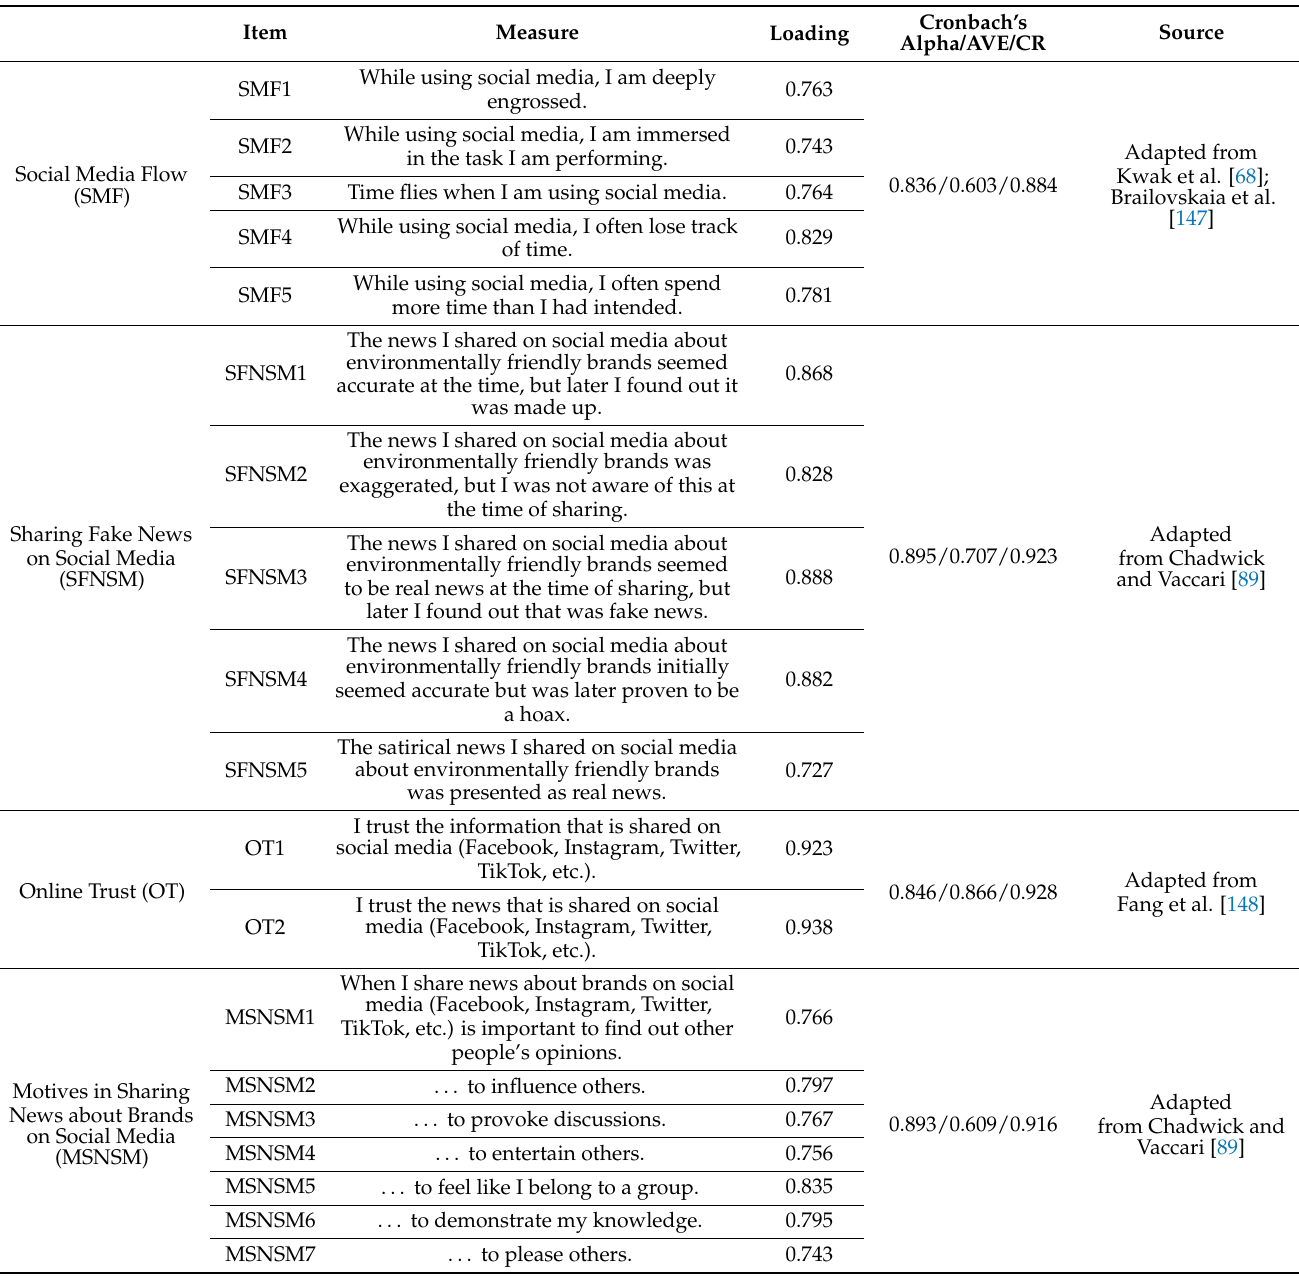
Table 2. Constructs and